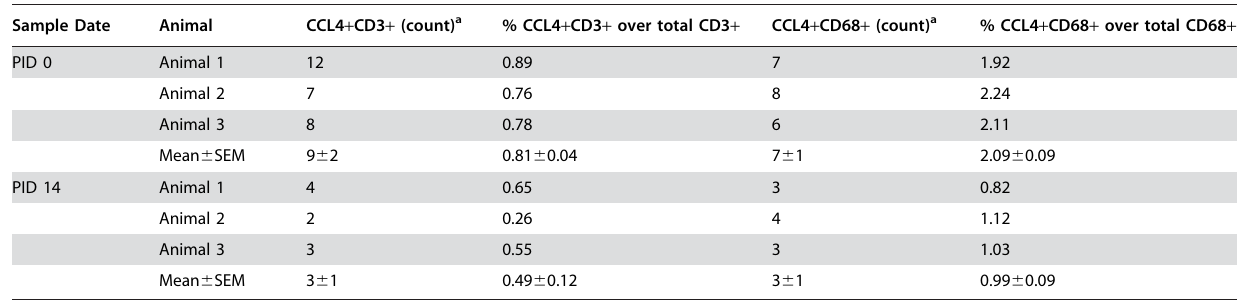
Table 1. Absolute (counts) and relative (%) levels of CCL4 + cells in MLN following SHIV SF162P4 inoculation .. ... .... ... ... .... ... ... .... ... ... .... ... ... .... ... ... .... ... ... .... ... ... .... ... ... .... ... ... .... ... ... .... ... ... .... ... ... .... ... ... .... ... ...